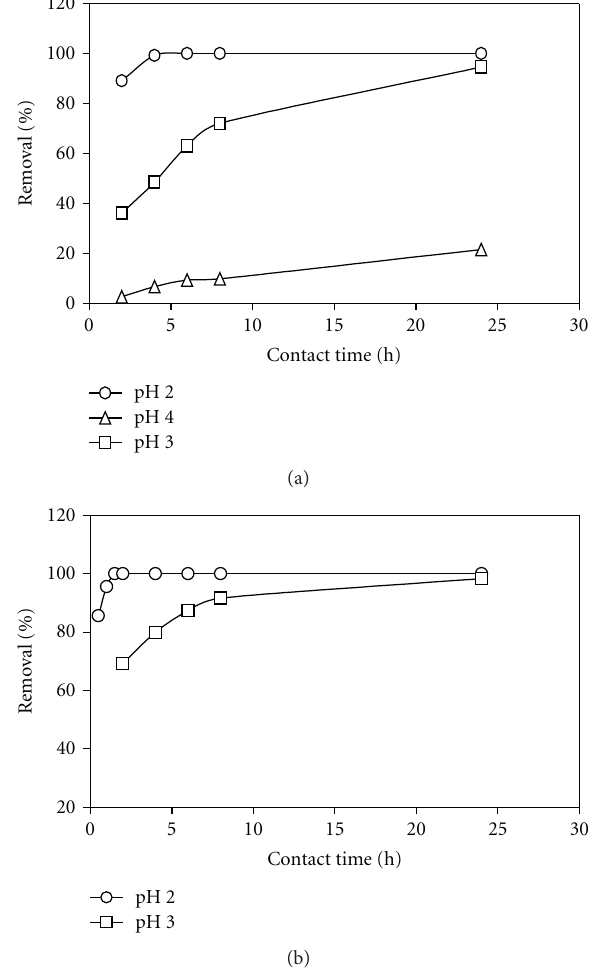
F 7: Acidic dye adsorption capacity of PC as a function of pH and contact time (adsorbent dosage, 500 mg per 100 mL; dye ). concentrations, 50 mg L −1